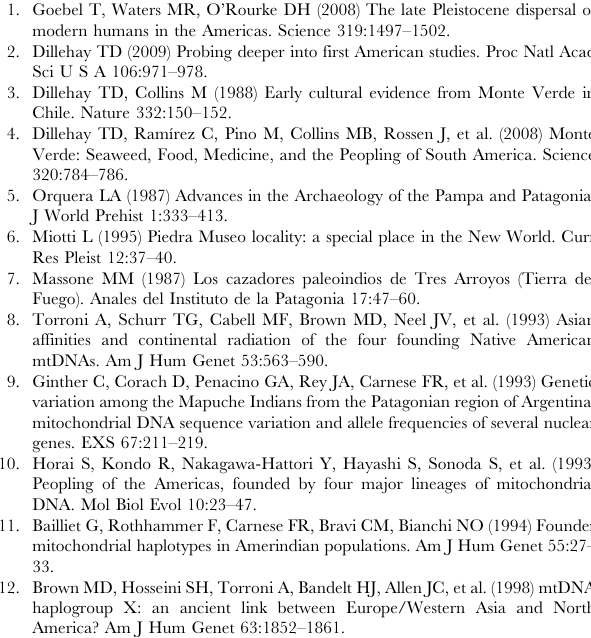
Figure S2 Dendrogram Neighbor Joining built from genetic distances obtained from the pairwise Fst analysis. Figure S3 Phylogenetic tree for D4h3a & D1. This tree include 7 new complete mtDNA sequences (red numbers), and 7 previously reported (blue numbers, table S6). The position of the revised Cambridge Reference Sequence (rCRS) (Andrews et al. 1999) is indicated for reading off sequence motifs. Table S1 Geographic location and molecular basic indices of studied populations